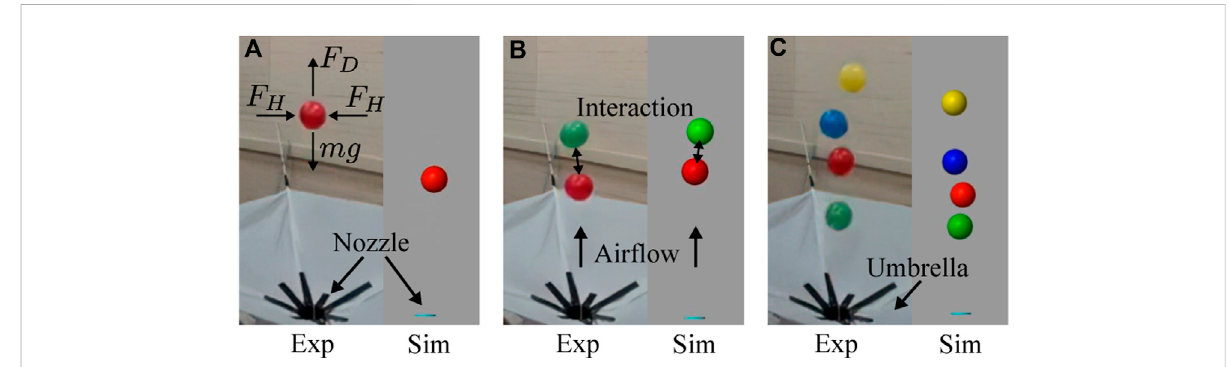
FIGURE 1 ThecollectiveBernoulli-ballsystemwith1 (A) ,2 (B) ,and4 (C) ballsinexperimentsandsimulation.Theverticalair fl owcomesoutofthenozzleto providedragforces( F D )andhorizontalforces( F H )totheballs.Interactionsemergebetweenmultipleballs.Theumbrellaisusedtocollectfallingballs and put them back into the air fl